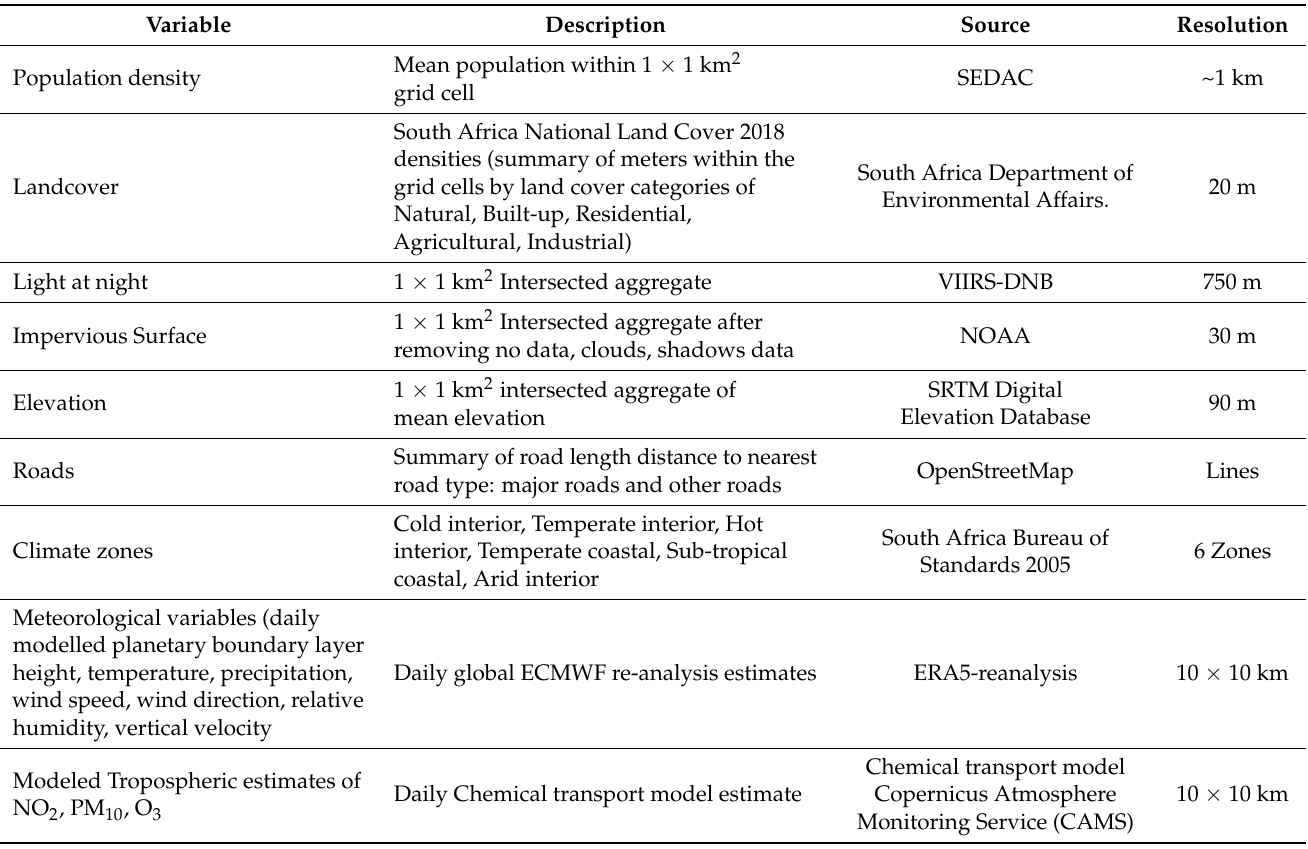
Table 1. Spatial and temporal predictors used for random forest